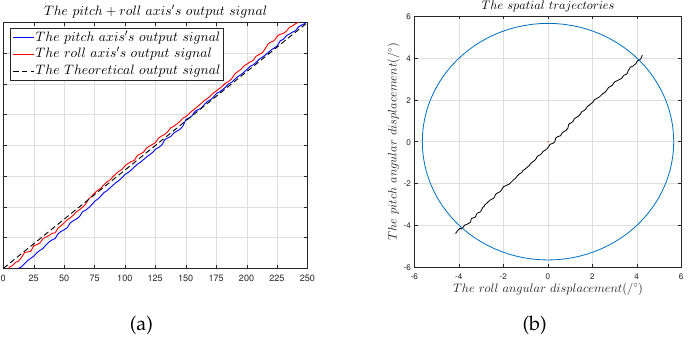
Figure 19. Dual-axis measurement experiments in the 45° direction: ( a ) solution results of the angular displacement signals α 1 and α 2 ; ( b ) 45° displacement trajectories fitted by α 1 and α 2 .